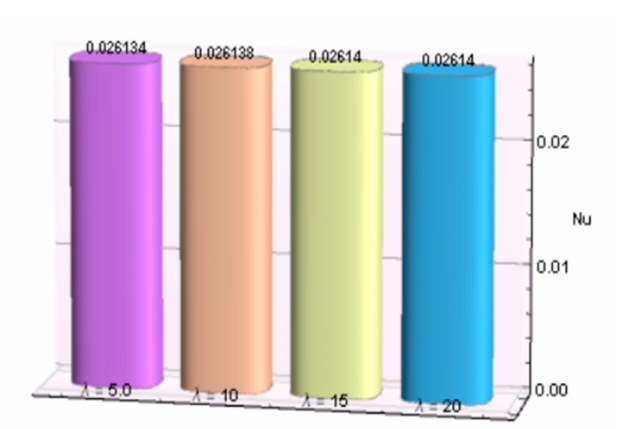
Figure 21. β verses Nu .